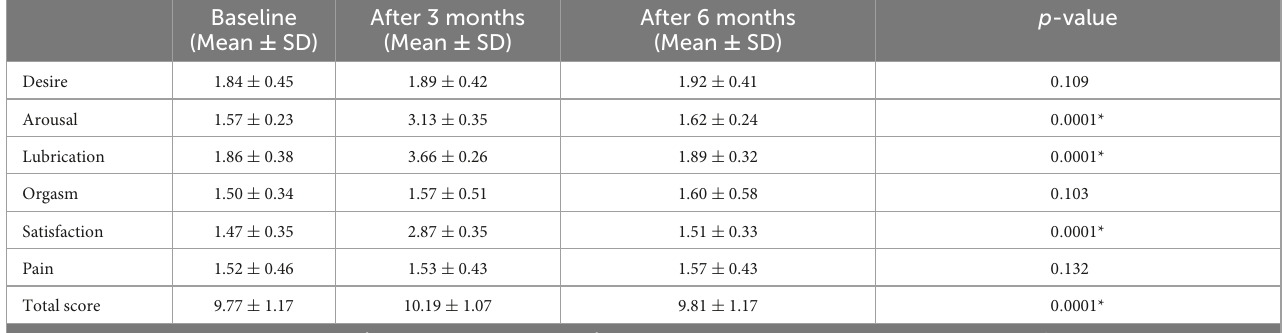
TABLE 3 Sexual function assessed by the Arabic FSFI among the three assessment times.